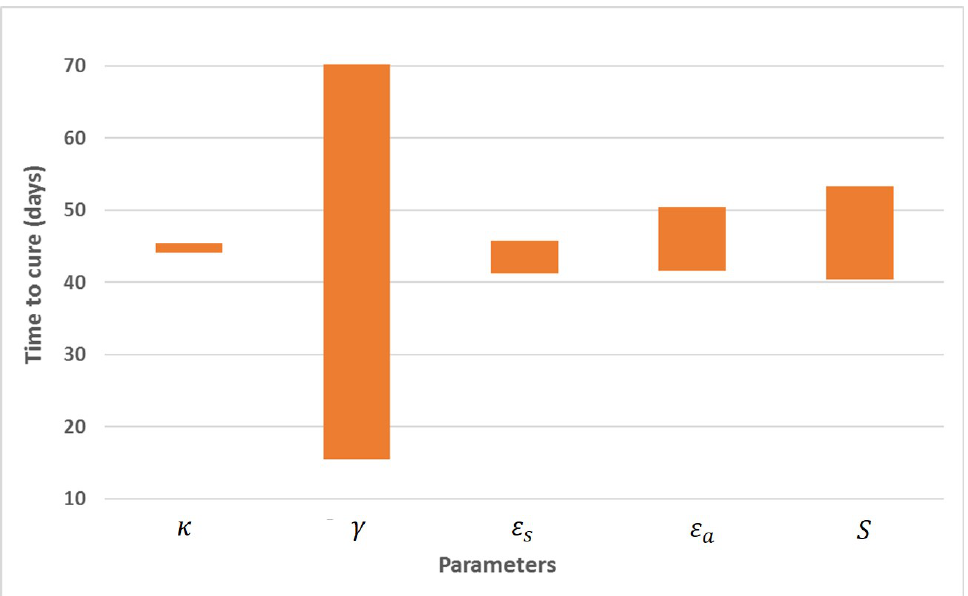
Figure 4. One-way sensitivity analysis of time-to-cure using the multiscale model. Depicted are minimum and maximum time-to-cure values for each parameter that were varied in a defined range (i.e., κ (3.5–6.7), γ (0.2–0.96/day), (cid:101) s (0.4–0.8), (cid:101) a (0.9–0.999), and s (4.62–6.48 log(cells/mL)), while the other parameters were fixed as follows: β (0.00000005 mL/day/virion), δ (0.14/day), ρ (8.18/day), c (22.3/day), d (0.01/day), α (40.0 vRNA/day), and µ